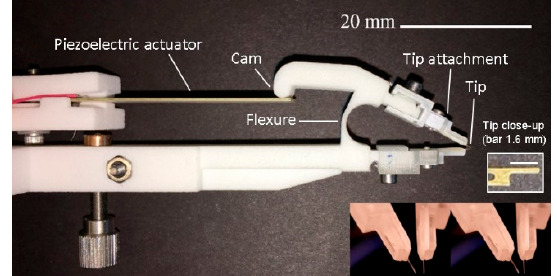
Figure 4. Photograph of the tweezer system.